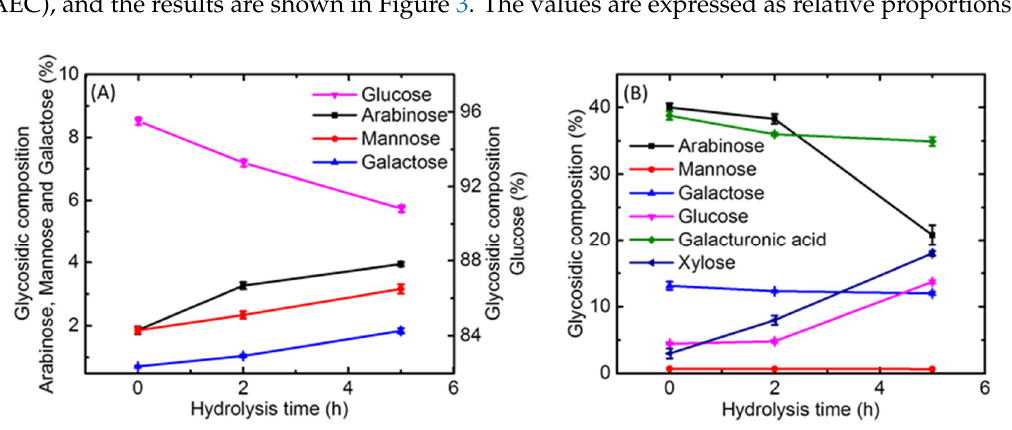
Table 4. Relative proportions of the five fractions of the water-soluble polysaccharides in longan juice before (0 h) and after enzyme treatment for 2 h and 5 h *.